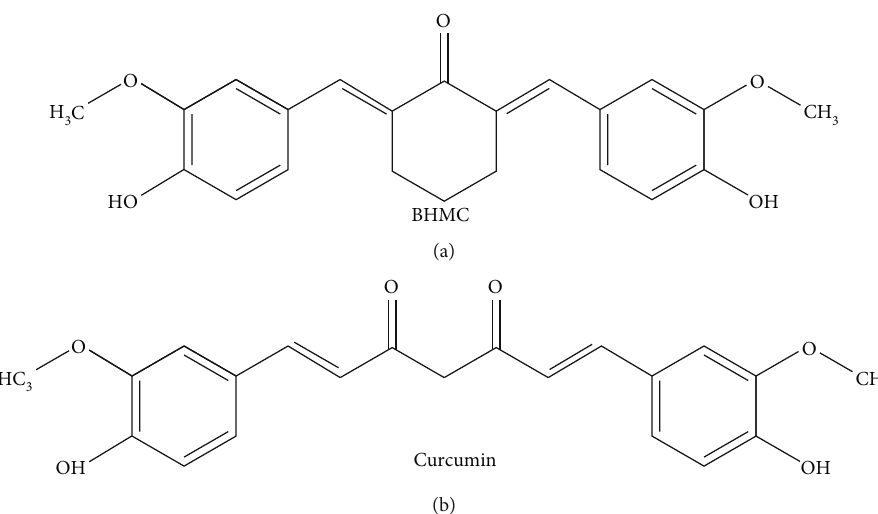
Figure 1: The chemical structure of (a) BHMC [2,6-bis-(4-hydroxyl-3-methoxybenzylidine)cyclohexanone] and (b)